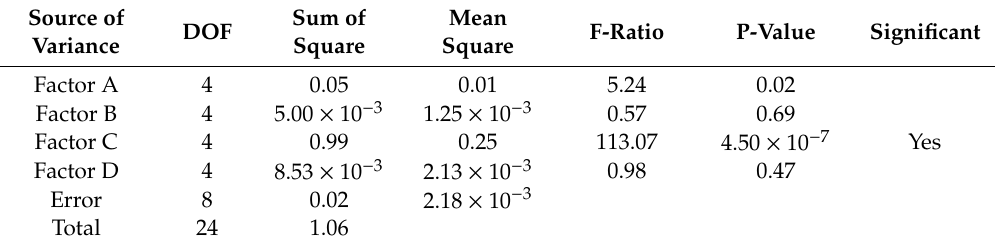
Table 9. Variance analysis of the DEI as obtained from the timberland damage assessment. Source